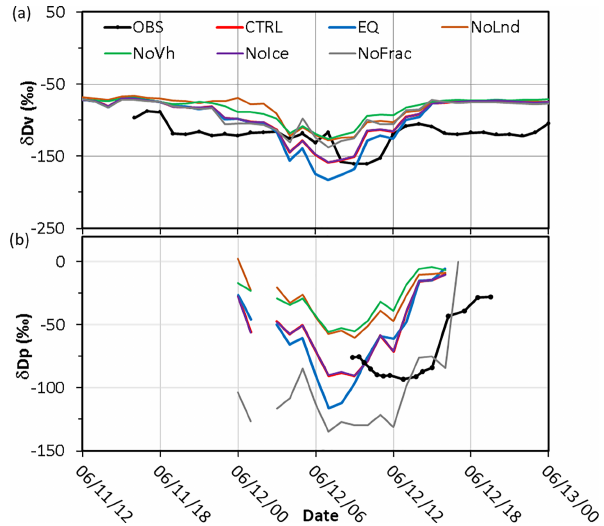
Figure 11. Same as Fig. 7 but for sensitivity simulations: the control run (CTRL; red line), thermodynamic equilibrium run (EQ; blue line), no-ice run (NoIce; purple line), no-land run (NoLnd; orange line), constant initial vertical profile run (NoVh; green line), and no-fractionation run (NoFrac; grey line).